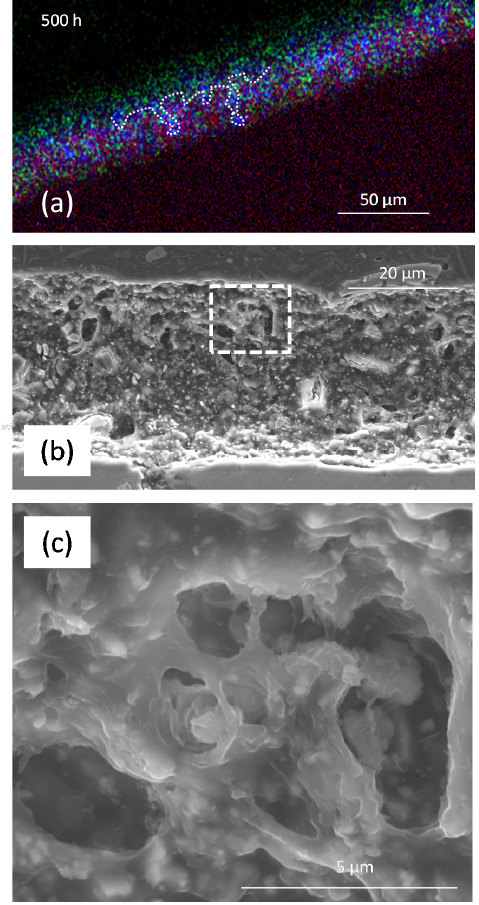
Figure 14. ( a ) Example of the local dissolution front on the three-colour map of the sample exposed to NSS for 500 h. ( b ) Secondary electron image of the distribution of voids within a region of the sample exposed to NSS for 500 h. ( c ) Enlargement of the region within the square in ( b ) showing the connectivity between the voids. The voids are assumed to be due to the dissolution and loss of Li 2 CO 3 particles.